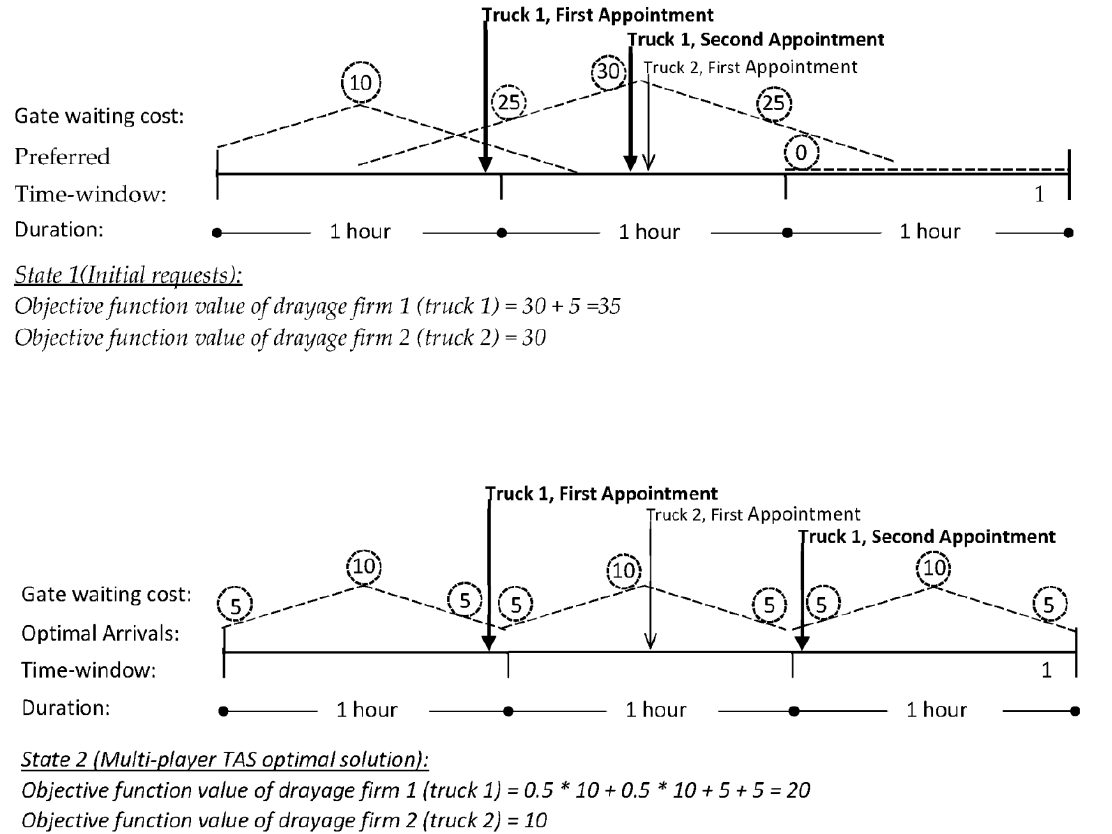
Figure 4. Solution of illustrative example using multi-player TAS.